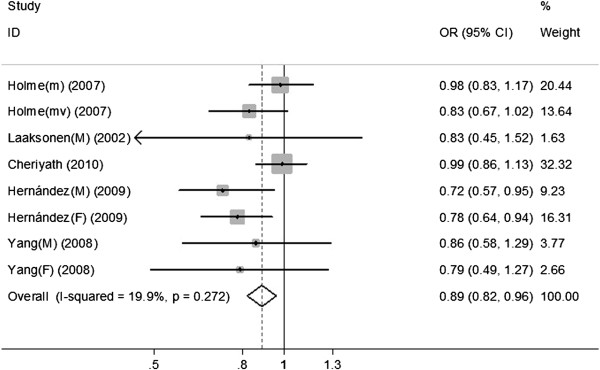
Forest plots for the risk of MS associated with the moderate level LPA. CI, confidence interval; LPA, leisure-time physical activity; MS, metabolic syndrome, OR, odds ratio.